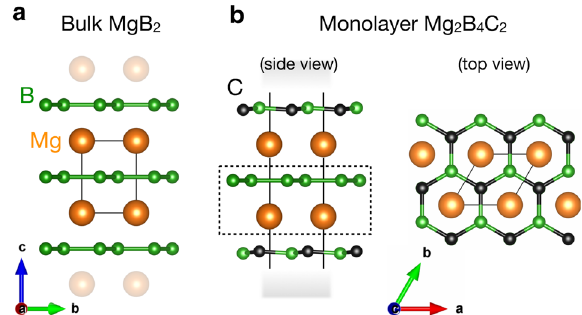
Fig. 1 Crystal structure. a Bulk MgB 2 , and ( b ) side (as viewed from ! a ) and top views of monolayer Mg 2 B 4 C 2 (Mg: orange, B: green, C: black). Solid black lines mark the unit cell boundaries, and shaded grey areas represent vacuum in the left panel of ( b ). The region marked by dashed black lines in ( b ) can be arbitrarily repeated (see